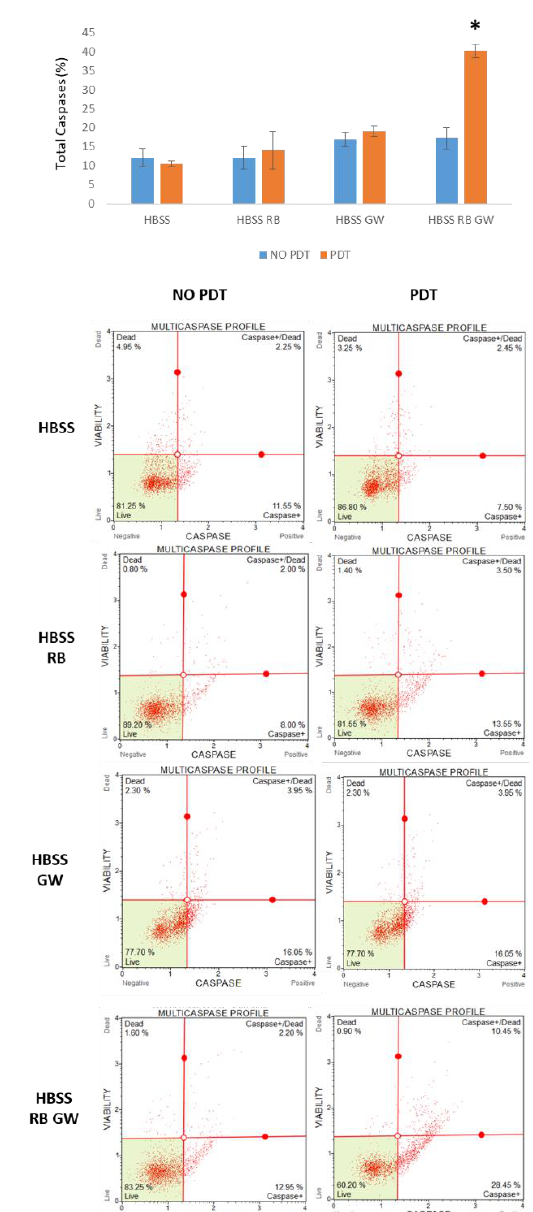
Figure 11. Caspases cytometric analysis of T98G cells following RB starvation, PDT exposition and GW4869 administration scheme. Cells were starved for 30 min in HBSS media, singled treated with RB (0.75 μ M) or GW4869 (GW = 5 μ M) or with the RB-GW combination, and exposed or not to PDT (2 min at 562/576 nm). Trypsinized cells were finally analyzed after 24 h p.t. in standard growing media for apoptosis induction using the Guava Muse MultiCaspase kit (Luminex). ( A ) The histogram of mean percentages of Total Caspases (i.e., Caspase 1, 3, 4, 5, 6, 7, 8, and 9) positive cells (Caspase + Dead and Caspases + events) of two independent experiments is reported ( n = 2000 each). Asterisks indicated statistical significance of HBSS, RB, GW and PDT-exposed cells compared to the remaining samples ( p < 0.05, ANOVA one-way; SD are highlighted as vertical bars). ( B ) Examples of cytofluorimetric MultiCaspase plots.